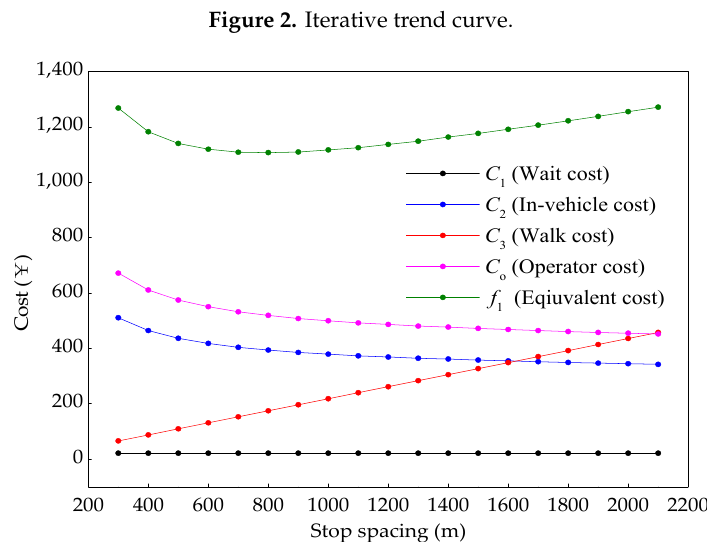
Mathematics 2019 , 7 , x FOR PEER REVIEW